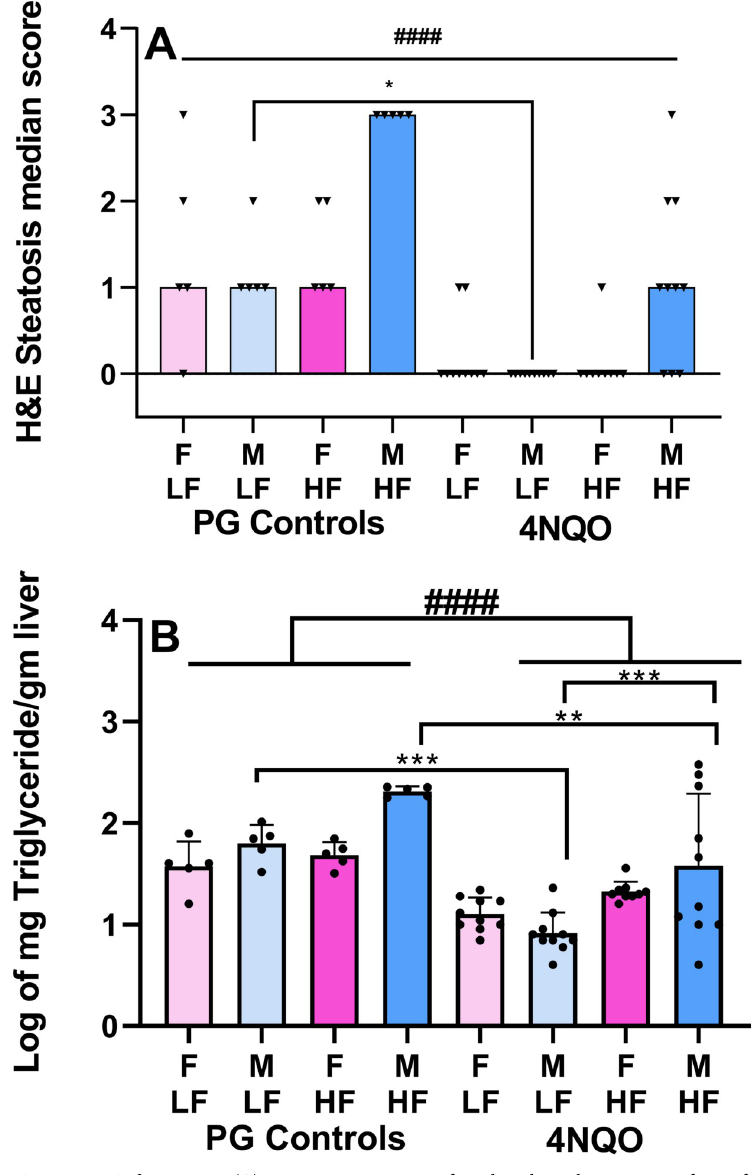
Fig 2. Hepatic fat content. (A) Hepatic steatosis score from histological assessment of mice from all treatment groups. Data shown are median values. #### refers to the Kruskal-Wallis statistical analysis. � refers to the Dunn’s post-hoc test for multiple comparisons. (B) Log of triglyceride levels in livers of mice from all treatment groups. Data shown are mean values ± SD. #### refers to the 3-way ANOVA. � refers to results from the Bonferroni post-hoc test for multiple